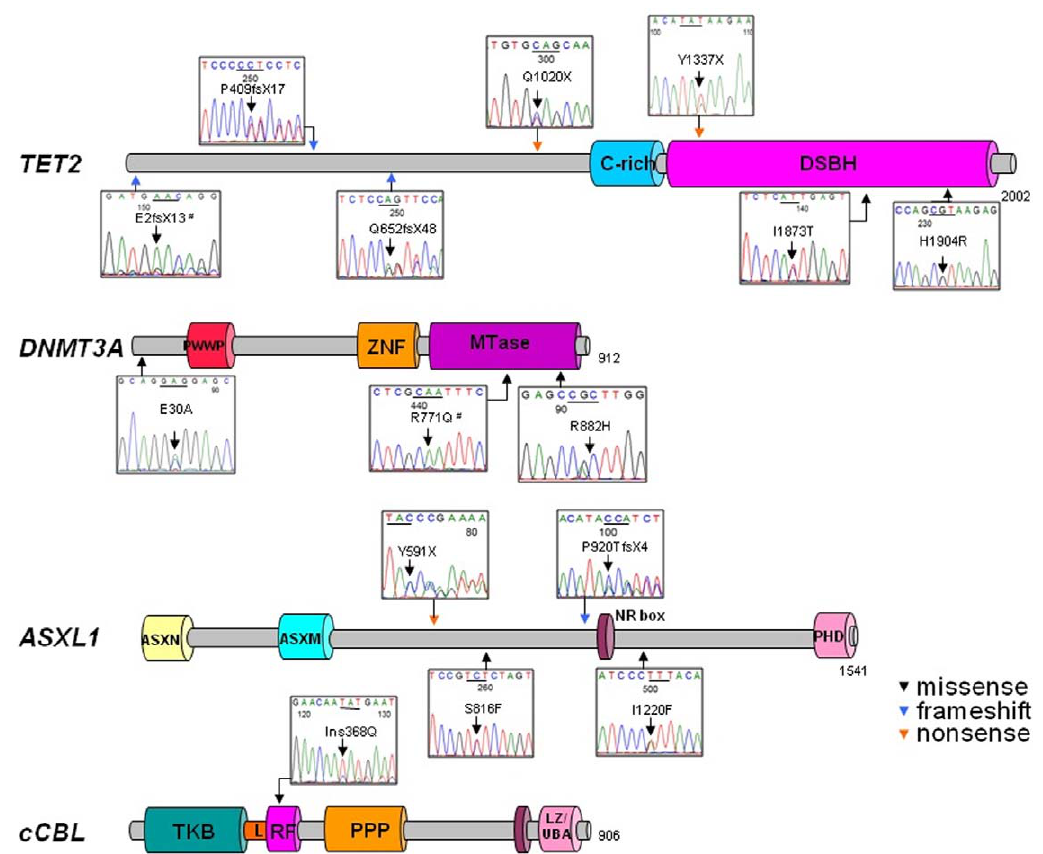
Figure 2. Localization of mutations identified in systemic mastocytosis. In a cohort of 26 patients with systemic mastocytosis, 14 mutations were identified. Genomic sequencing of protein-coding regions and splice sites revealed missense (black), nonsense (orange), and frameshift mutations (blue) in TET2 , DNMT3A , ASXL1, and CBL . Most mutations were found in conserved domains and specific known conserved motifs and domains are shown for each protein: cysteine-rich region (C-rich-), double strand aˆ helix (DSBH), PWWP domain (characterized by the presence of a highly conserved proline–tryptophan–tryptophan–proline motif), ADD ( ATRX, DNMT3, and DNMT3L )-type zinc finger (ZNF) domain, methyltransferase (MTase) domain, amino-terminal ASX homology (ASXN) region, ASXM domain, nuclear receptor coregulator binding (NR box) motifs, carboxyterminal plant homeodomain (PHD) domain, tyrosine kinase binding (TKB) domain, linker sequence (L), RF domain (RF), proline-rich region (PPP), and leucine zipper LZ/ubiquitin-associated domain (UBA). Two changes occurred in a homozygous state, as indicated by the symbol # and the others in heterozygous state.